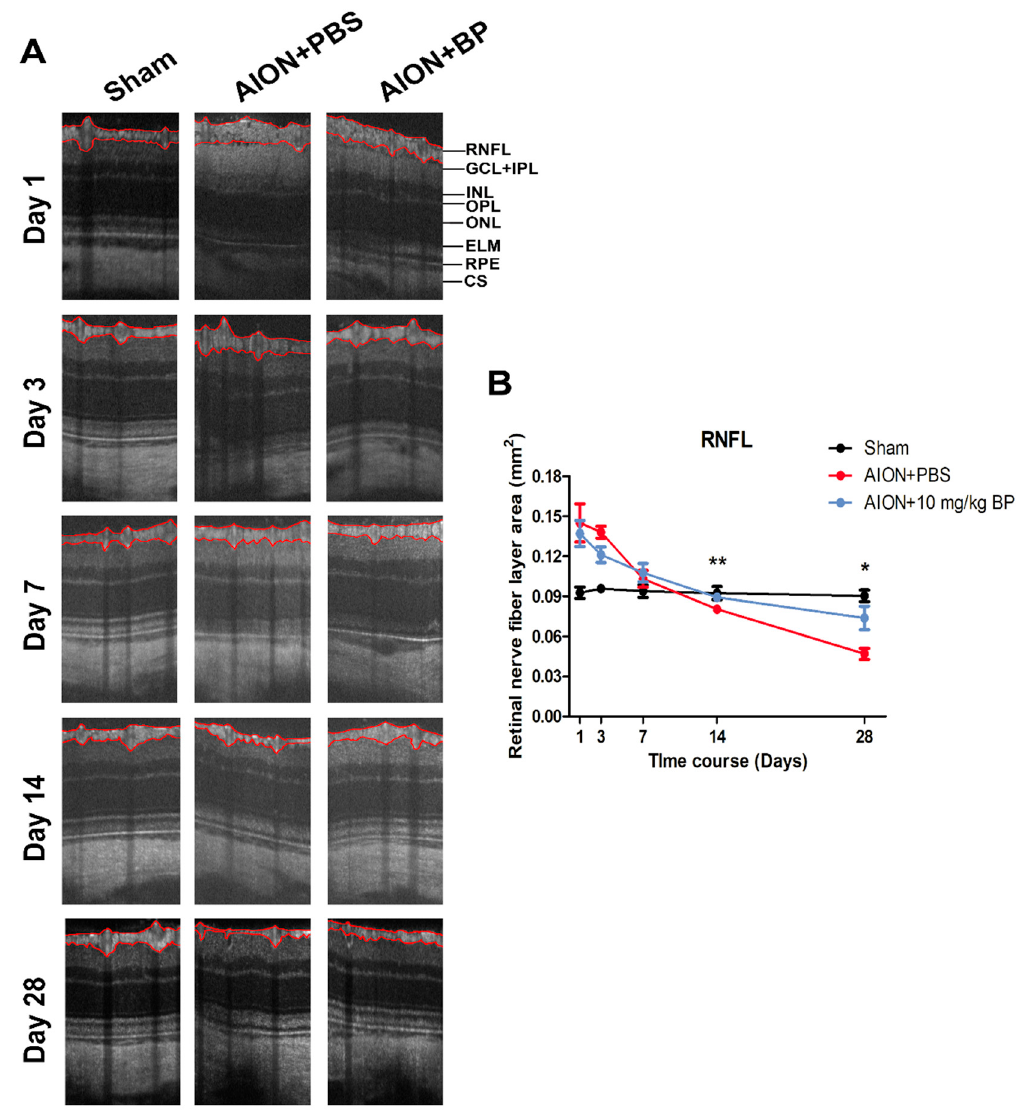
Figure 4. Image of the retinal nerve fiber layer by OCT scanning. OCT images of RNFL thickness in each group on days 1, 3, 7, 14, and 28 ( A ). The BP-treated group exhibited significant maintenance of RNFL thickness at days 14 and 28 compared with the PBS-treated group (0.089 ± 0.0027 mm 2 versus 0.08 ± 0.0028 mm 2 and 0.074 ± 0.0089 mm 2 versus 0.047 ± 0.0042 mm 2 , respectively) ( B ). (**, p ≤ 0.01; *, p ≤ 0.05; n = 6. RNFL: retinal nerve fiber layer; GCL + IPL: ganglion cell layer + inner plexiform layer; INL: inner nuclear layer; OPL: outer plexiform layer; ONL: outer nuclear layer; ELM: external limiting membrane; RPE: retinal pigment epithelium; CS: choroidal stroma.)